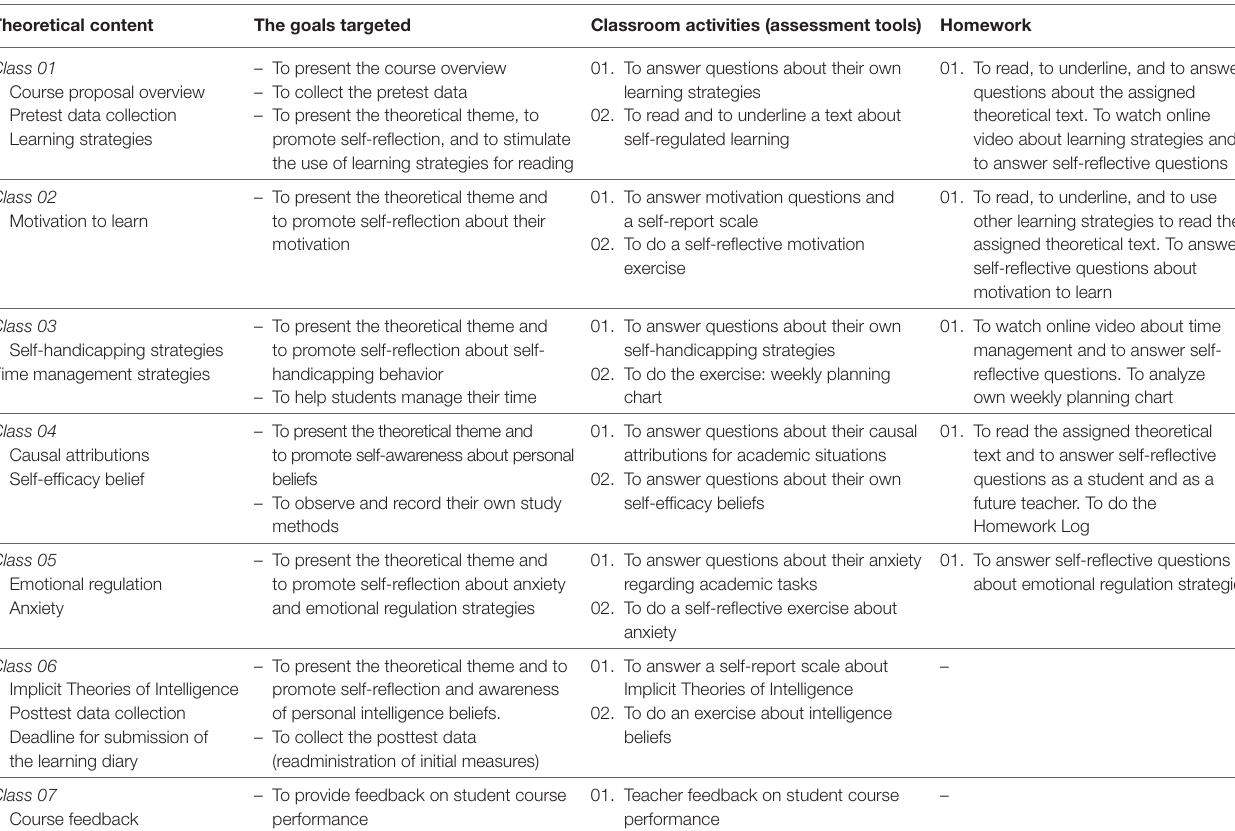
TaBle a1 | Overview of course content, classroom activities assessment tools, and the goals targeted in intervention program format—Experimental Group I.